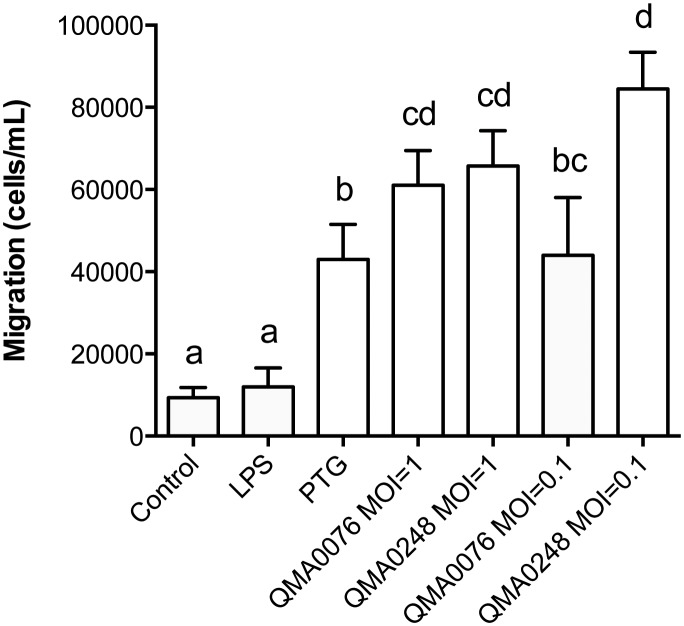
Barramundi DCs migration towards different chemical cues.Different letters represent statistically significant differences. Barramundi DCs migrated significantly towards all cues (p < 0.001 for PTG, QMA0076 and QMA028 at MOI 1 and QMA0248 at MOI 0.1; p < 0.01 for QMA0076 at MOI 0.1) with the exception of LPS, which bDCs did not migrate towards significantly (p = 0.076).